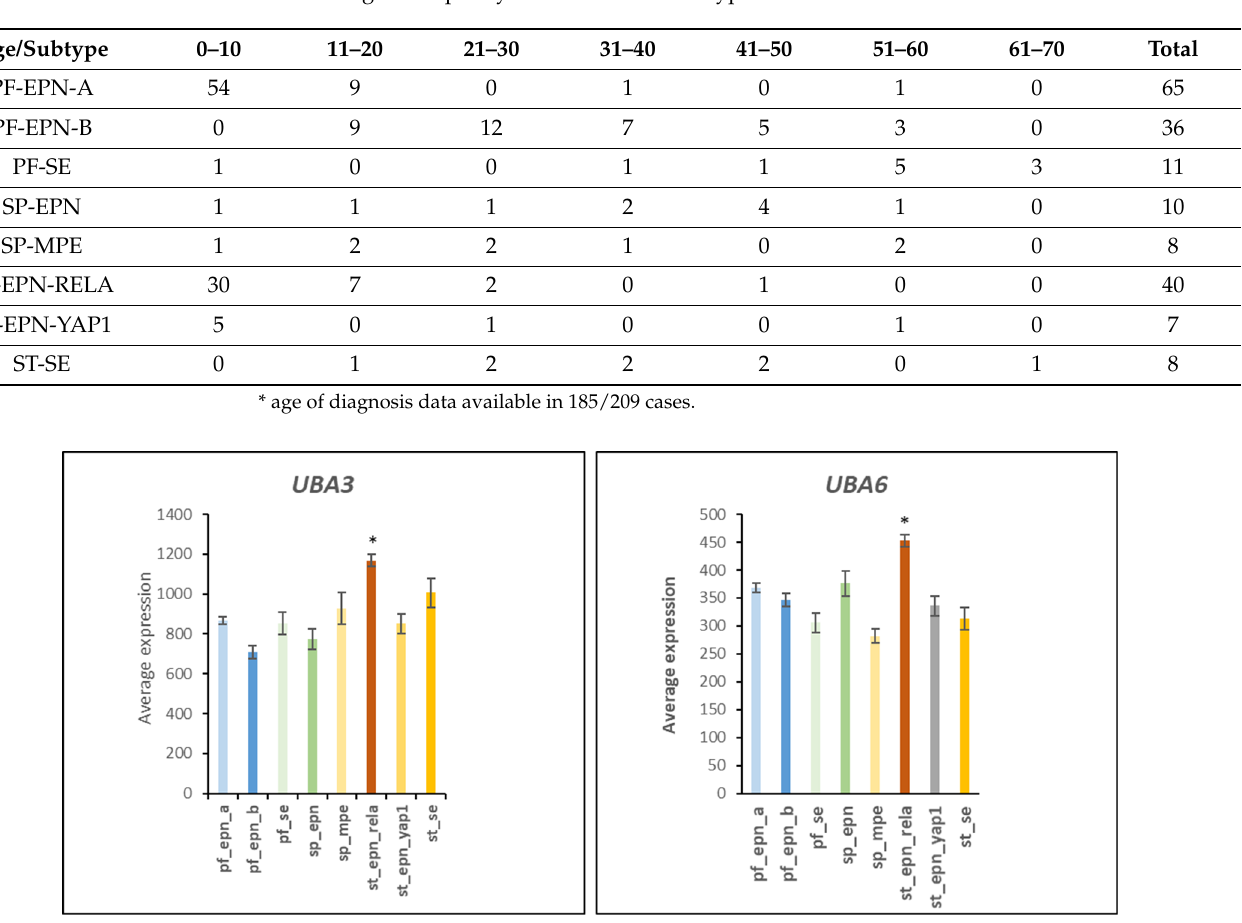
Table 1. Age and ependymoma cases * in subtypes of the Pfister dataset. Dataset GSE64415.